Question: Condense the content of this figure into a single sentence.
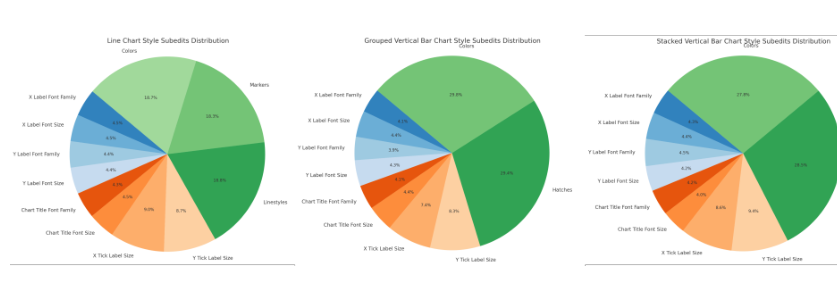
Answer: Distribution of Samples for Style Edits across Chart Categories